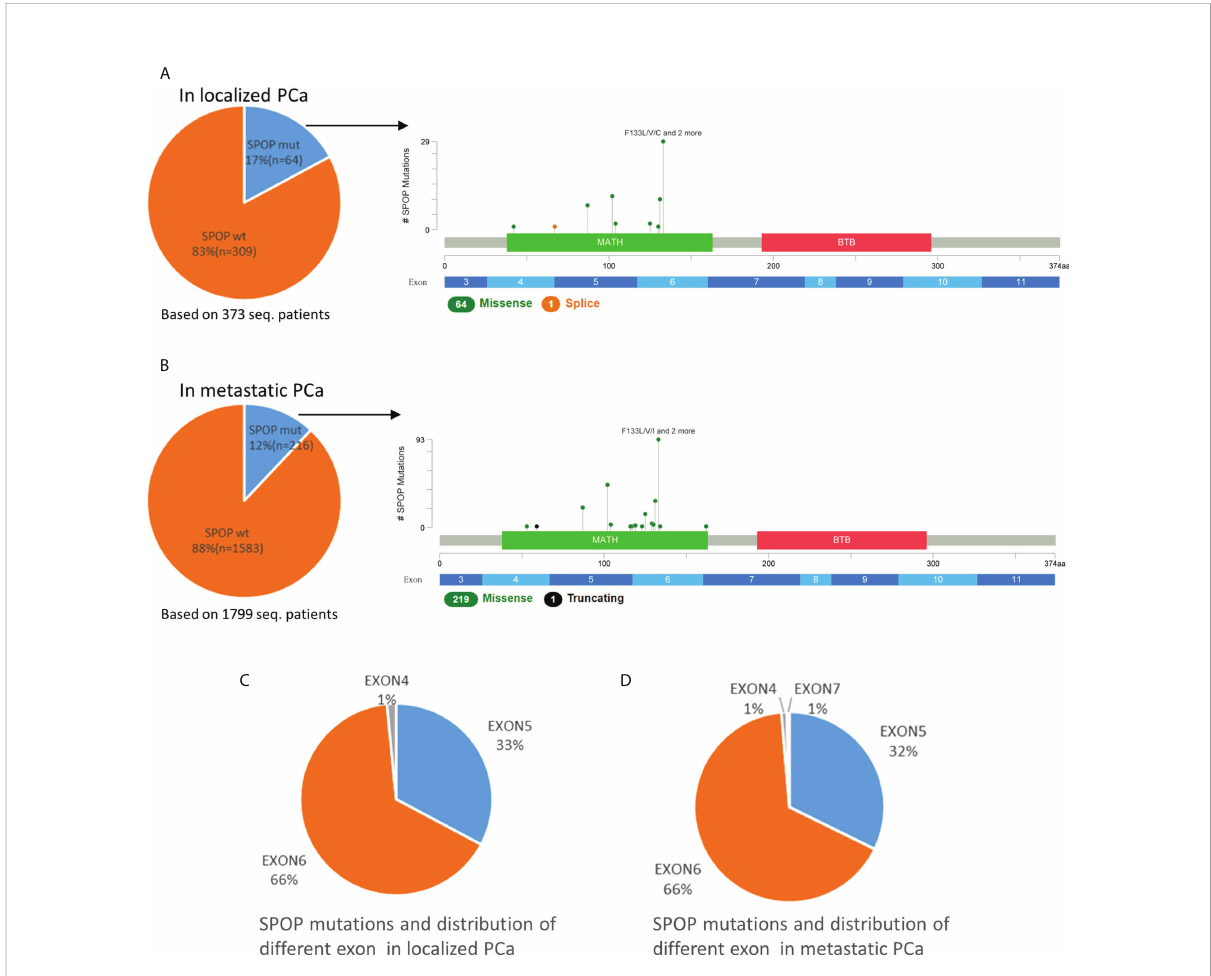
FIGURE 2 Mutation mapping for SPOP in localized PCa (A) and metastatic PCa (B) . Distribution of different SPOP mutation site in localized PCa (C) and metastatic PCa (D) . aa, amino acid; seq., sequencing; SPOPwt, SPOP wild type; SPOPmut, SPOP